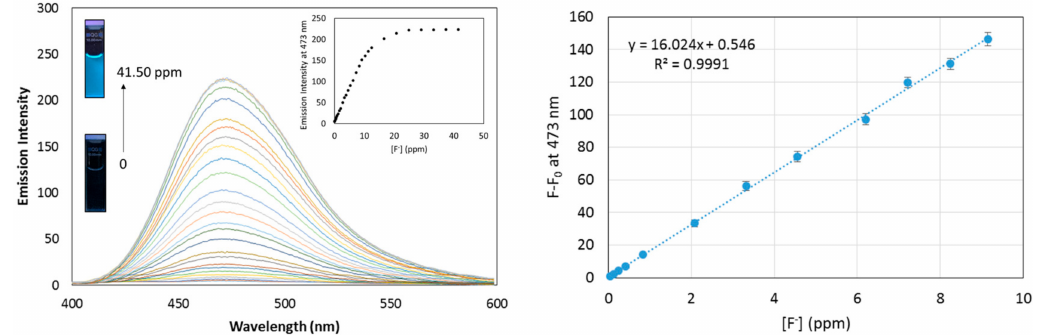
Figure 8. ( Left ) Fluorescence spectra of 5 (2 µ M) upon incubation with various amounts of fluoride (final concentration: 0, 0.04, 0.12, 0.24, 0.42, 0.60, 0.82, 1.24, 1.60, 2.08, 2.72, 3.32, 3.86, 4.56, 5.32, 6.20, 7.22, 8.25, 9.15, 10.25, 11.32, 12.48, 16.63, 20.78, 24.90, 29.10, 33.20, 37.35, 41.50 ppm) in HEPES buffer solution pH 7.4 (contain 0.8% MeCN) at 40 min incubation time. ( Right ) Standard calibration curve demonstrating the fluorescence intensity increment at 473 nm ( n = 3) as a function of fluoride concentrations (0.04, 0.12, 0.24, 0.42, 0.83, 2.08, 3.32, 4.56, 6.21, 7.22, 8.25, 9.15 ppm) incubated with 5 (2 µ M) in HEPES buffer solution pH 7.4 (contain 0.8% MeCN) for 40